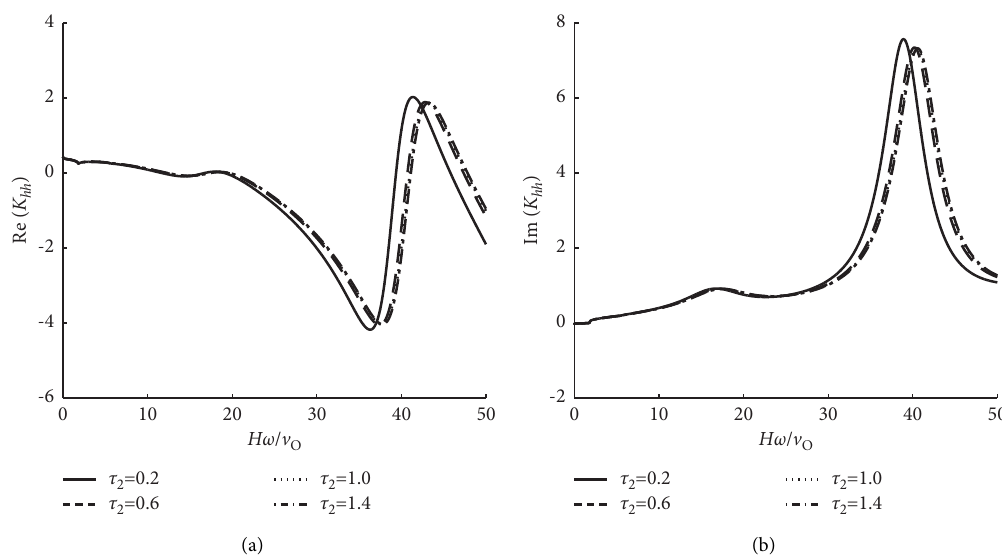
Figure 16: The horizontal dynamic impedance curves of pipe pile under different model parameter ratios ( τ horizontal dynamic impedance. (b) Imaginary part of horizontal dynamic